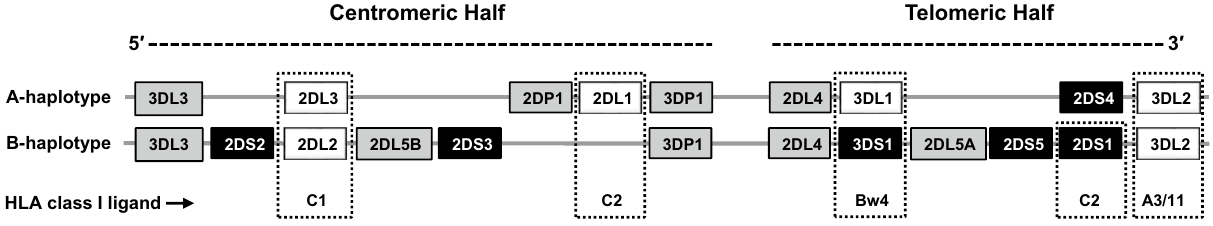
Figure 1. Map of group A and B KIR haplotypes. Distinct KIR haplotypes carry quantitively and qualitatively contrasting KIR gene content. Inhibitory KIR genes are depicted in white boxes. Activating KIRs are shown in dark boxes. Gray boxes represent pseudogenes or KIR genes with unclear function. HLA class I ligands for specific KIR are identified in dotted boxes. The centromeric and telomeric half are